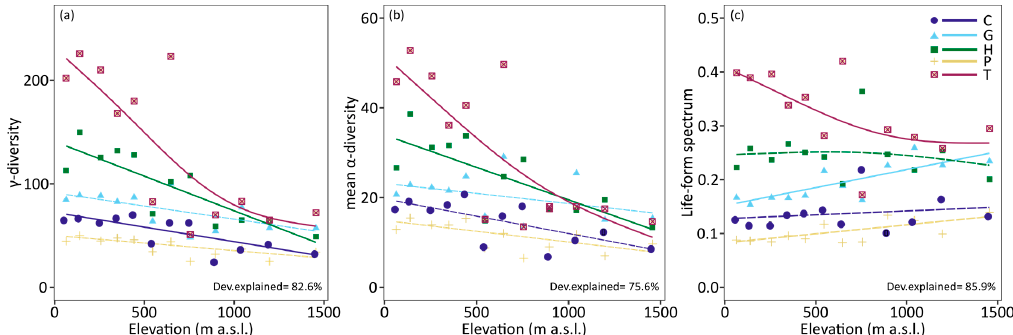
Figure 3. The relationship between elevation and ( a ) γ -diversity, and ( b ) mean α -diversity of different life forms, and ( c ) life form-spectrum and deviance explained of the formulated Generalized Additive Model (summary statistics of the models are presented in Supplementary Material—Table S4) across the 12 elevational zones. Points represent observed values and lines the predicted values by Generalized Additive Models predicting γ -diversity and mean α -diversity as function of elevation (smooth term) by life form and life form. Significant relationships are indicated by solid lines. Life forms abbreviations: C = chamaephytes, G = geophytes, H = hemicryptophytes, P = phanerophytes, T = therophytes.